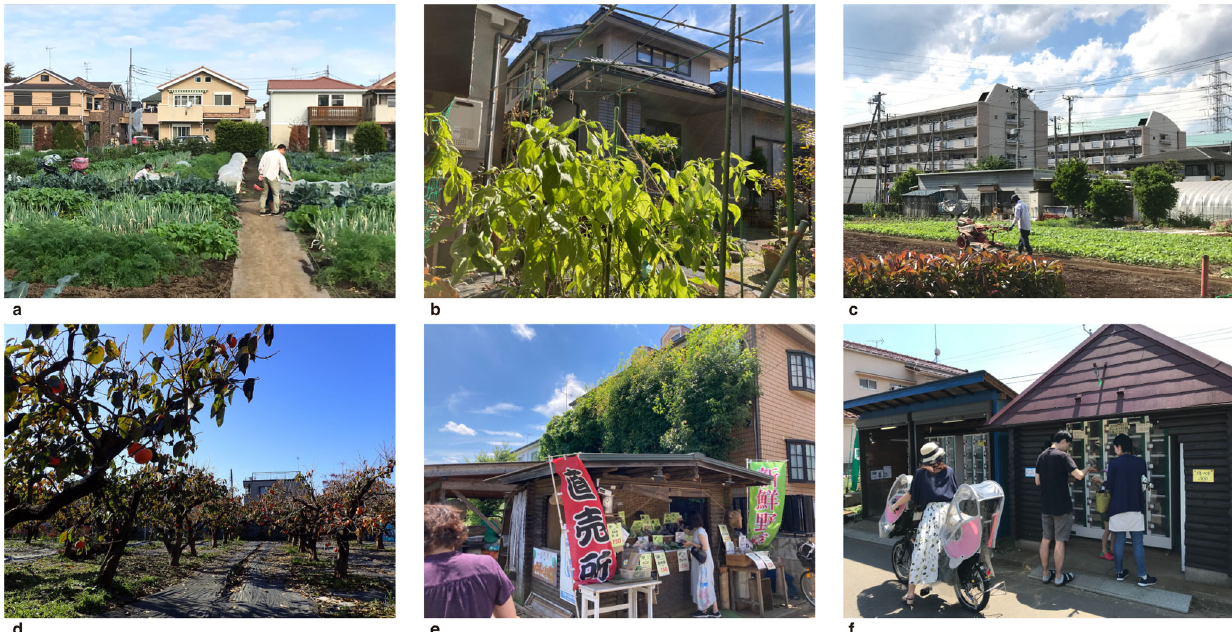
Fig. 2 Key places of urban agriculture in Japanese cities. a Allotment farms. b Home gardens. c , d Commercial urban farmlands owned by professional farmers in residential neighborhoods. A vegetable farm ( c ) and a fruit farm ( d ). e , f Farm stands called “ choku bai jyo ” : an open- type farm stand ( e ) and a vending machine-type farm stand ( f